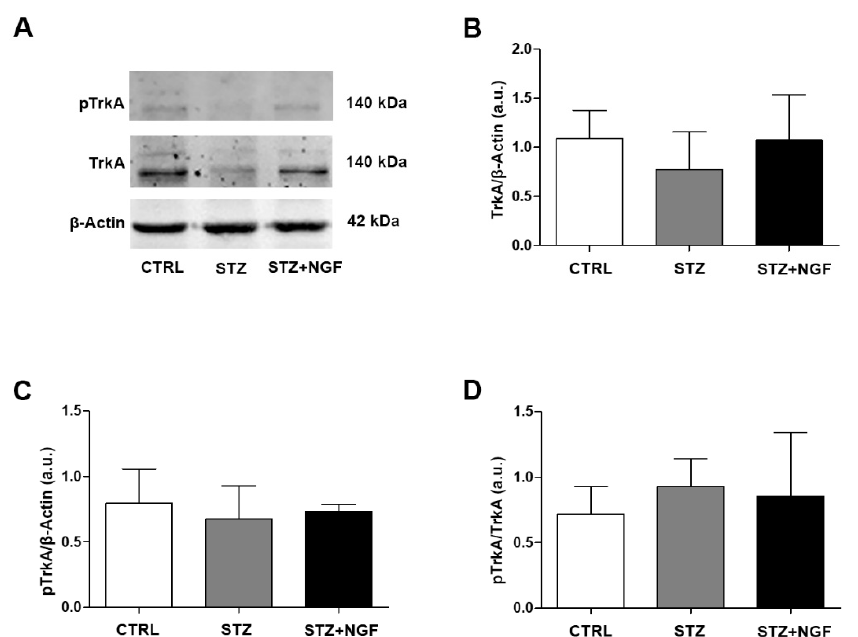
Figure 4. ( A – D ). Levels of TrkA and its phosphorylated status (pTrkA) in diabetic rat retina with or without NGF treatment. TrkA and pTrkA levels are shown in the experimental groups by Western Blot ( A ) and densitometric analyses ( B – D ). β -Actin expression was used to normalize sample vari- ability, a.u. indicates arbitrary units. The results are expressed as mean ± SD. CTRL, healthy rats; STZ, streptozotocin; STZ+NGF, streptozotocin+nerve growth factor eye drops.